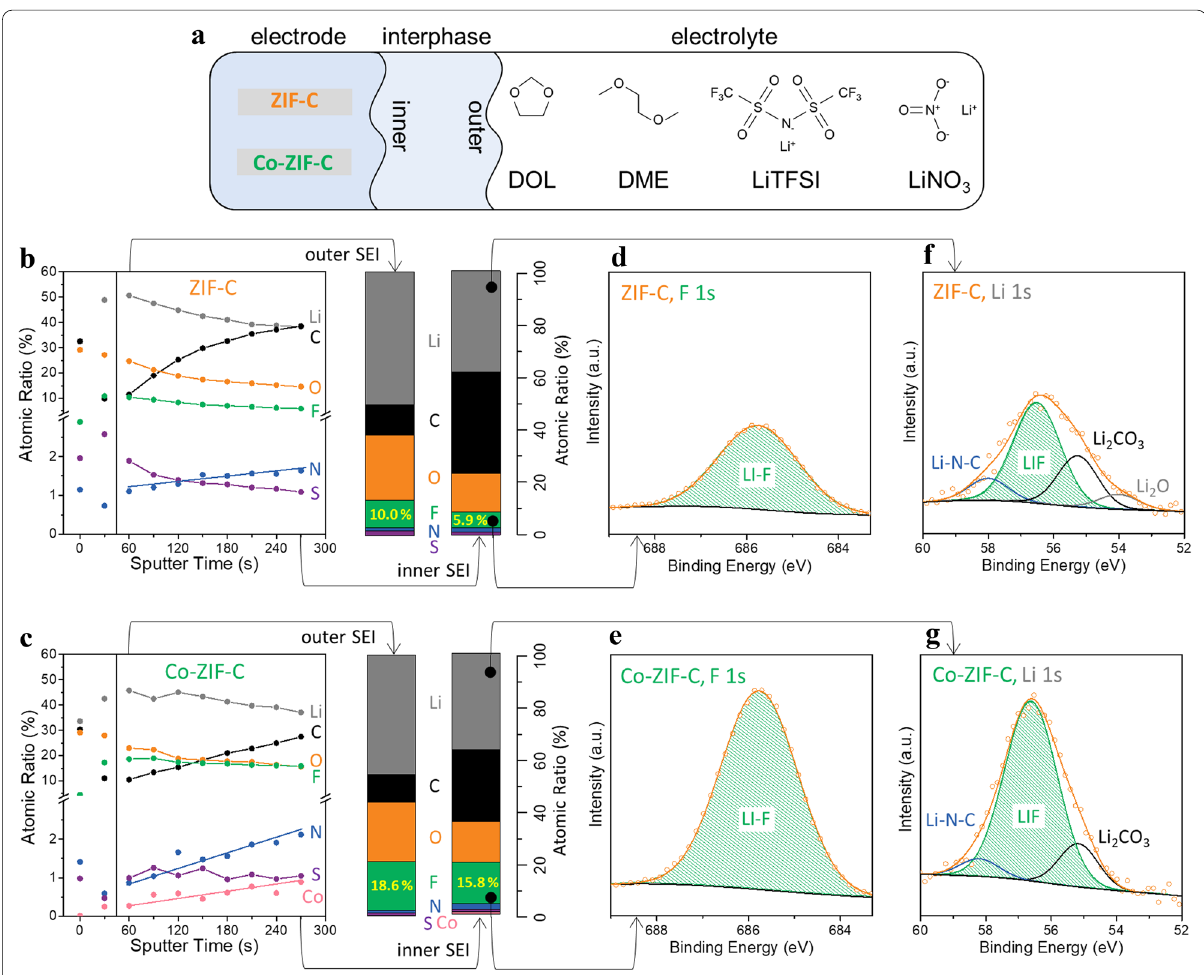
Fig. 4 a Schematic illustration of the components on the ZIF‑derived carbon electrodes, ether‑based electrolyte, and their interphases; XPS depth profiles of Li‑plated ( b ) ZIF‑C and ( c ) Co‑ZIF‑C electrodes; F 1 s spectra of ( d ) ZIF‑C and ( e ) Co‑ZIF‑C electrodes, and Li 1 s spectra of ( f ) ZIF‑C and ( g ) Co‑ZIF‑C